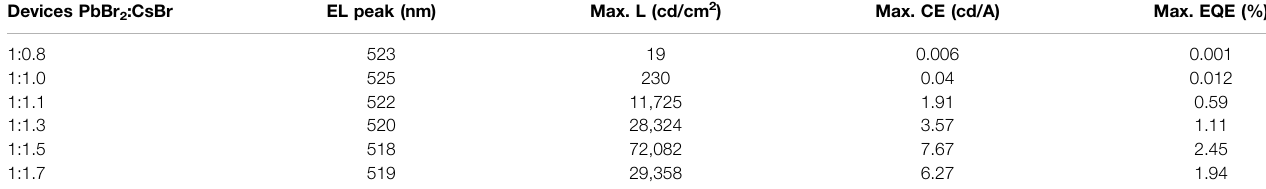
TABLE 1| Device performanceparameters oftheprepared PeLED devices based on thecorrespondingperovskite fi lms withdifferentmolarratios ofPbBr 2 and CsBr,such as 1:0.8, 1:1.0, 1:1.1, 1:1.3, 1:1.5, 1:1.7, respectively. Devices PbBr 2 :CsBr